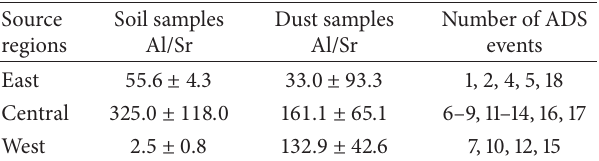
Figure 6: Comparison of the correlation percentages among back- ward trajectory calculation, enrichment factor, and grey relational analysis. Table 4: Comparison of the Al/Sr ratios for source soils and atmospheric particles sampled in the Inner Mongolia and at the Pescadores